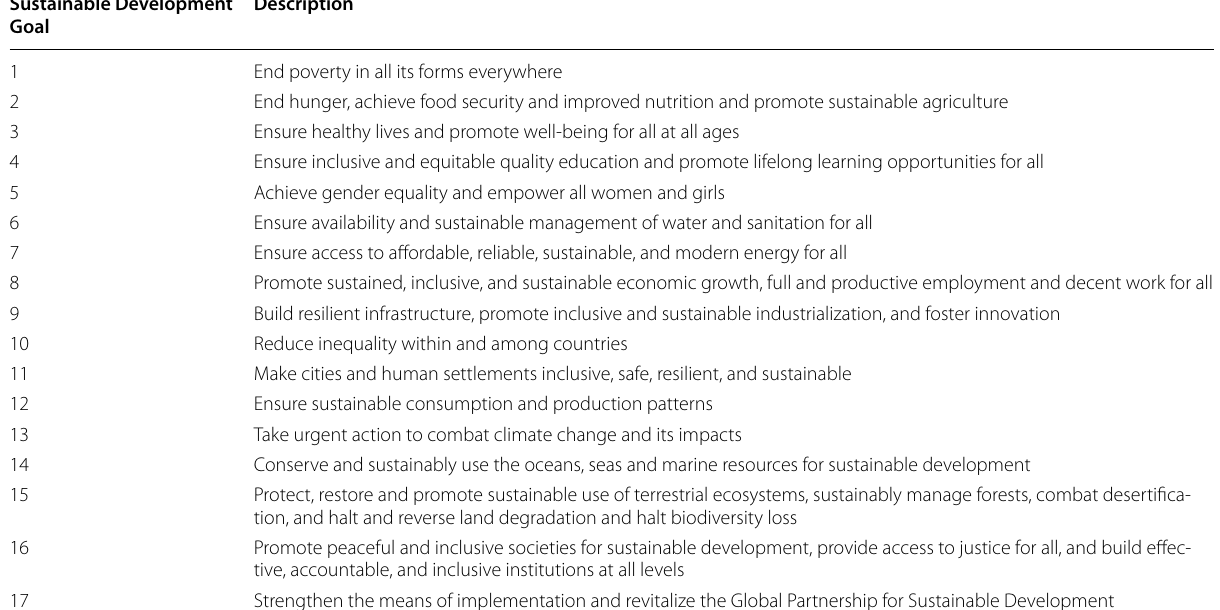
Table 1 The United Nations Sustainable Development Goals Sustainable Development